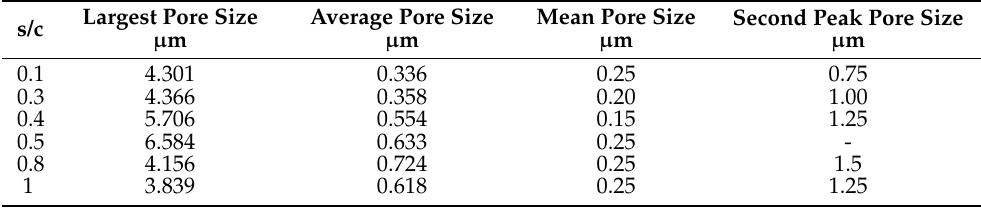
Table 1. Pore size distribution of membranes fabricated by a series of s/c ratios.